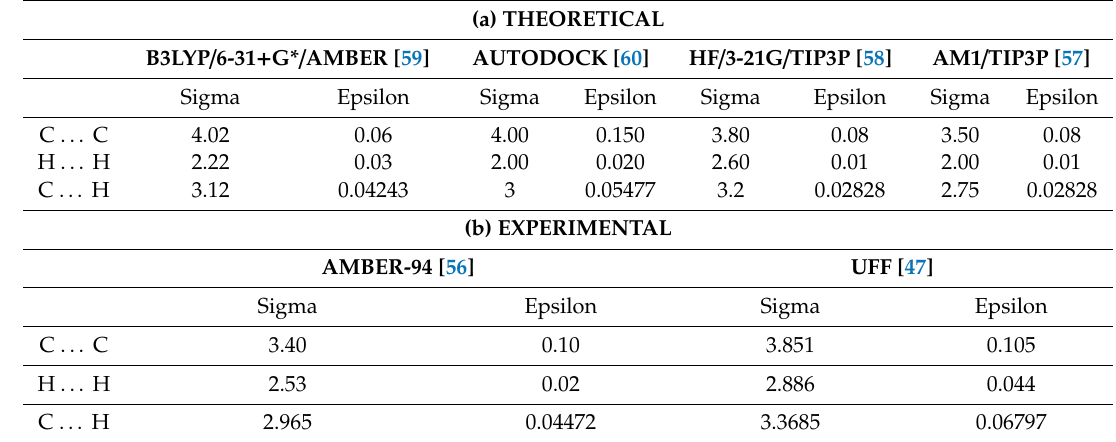
Table 3. Lennard Jones σ and (cid:15) values for (a) theoretically and (b) experimentally obtained